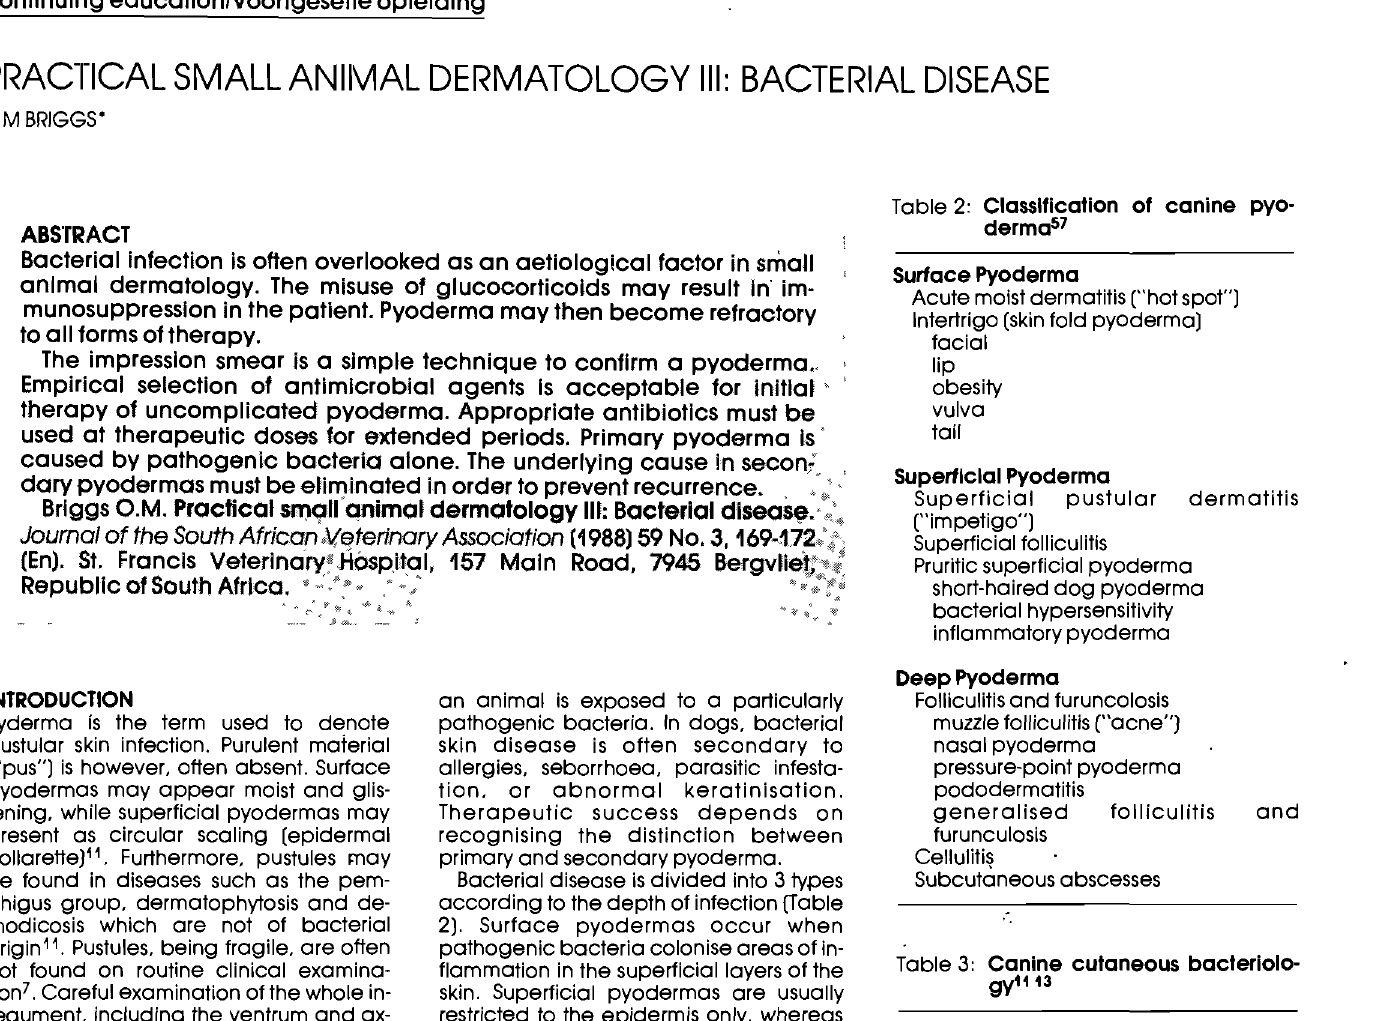
Table 3: Canine cutaneous bacteriolo gy1113 Resident organisms Coagulase-negative Staphylococcus